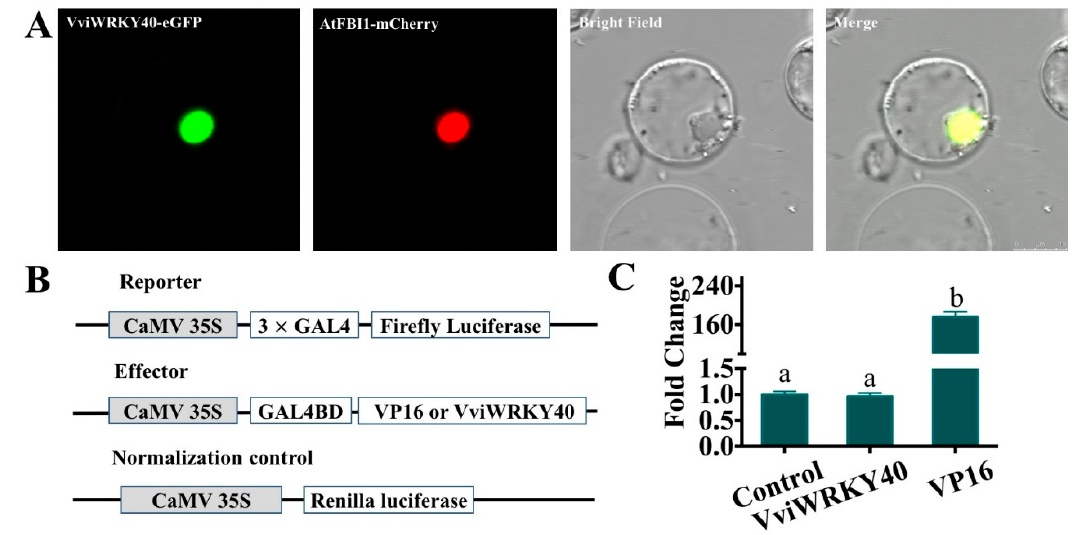
Figure 6. Subcellular localization and transcriptional activity assay of VviWRKY40 in Arabidopsis protoplasts. A. Subcellular localization of VviWRKY40 in Arabidopsis protoplast. The graphs from left to right represent VviWRKY40-eGFP, nucleus marker-mcherry, bright field, and the merge images, bar = 5 µ m. B. The reporter, e ff ector and normalized control constructs used in the transcriptional activity assay. C. Transcriptional activation domain analysis of VviWRKY40. The transcriptional activation function of VviWRKY40 was tested using the luciferase assay. The control represents empty pBD vector and its fold change is set as 1. VP16, an unusually potent transcriptional activator, is regarded as a positive control, and its activity change reaches 160-fold. The error bars represent SEs from at least six biological replicates. Significant di ff erences relative to the control are determined using the one-way ANOVA tests (**, P < 0.01).